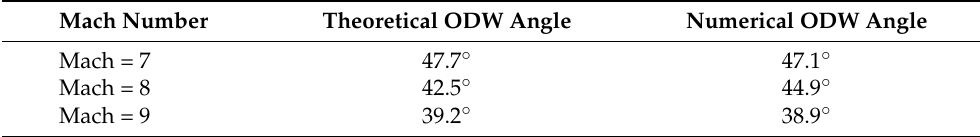
Table 2. Comparison of Theoretical and Numerical ODW Angles (No